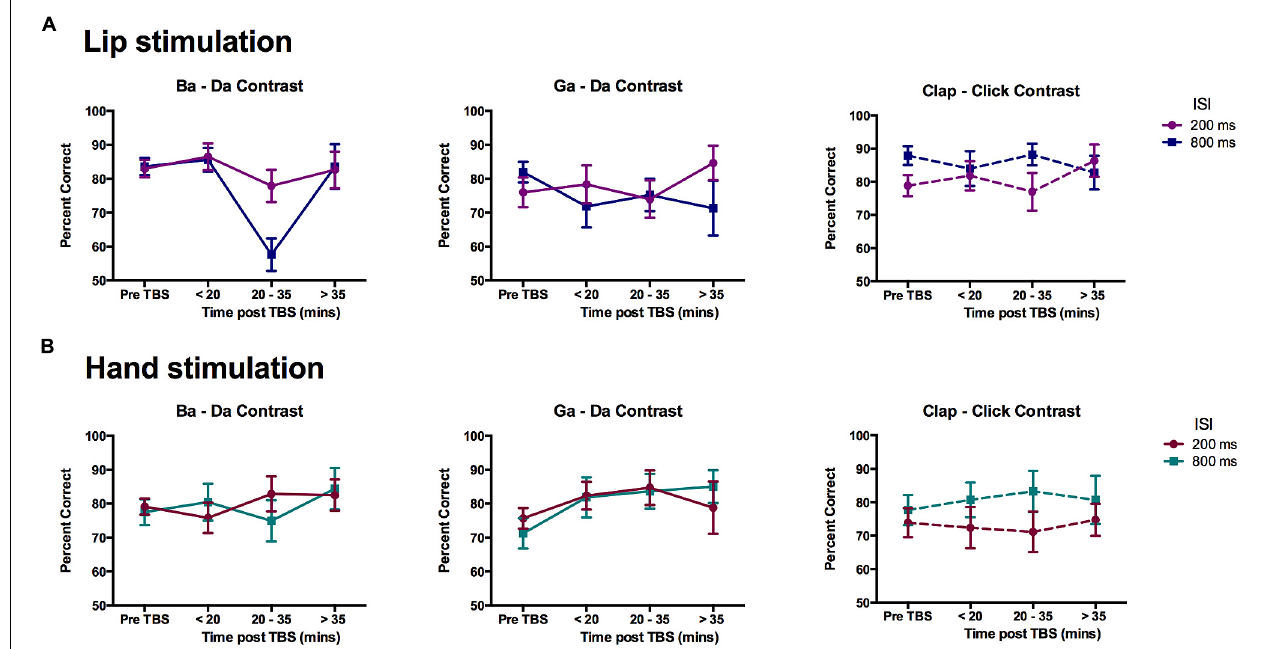
FIGURE 5 | Effects of cTBS on discrimination of across-category pairs. Mean percent correct scores for the participants in the (A) Lip stimulation group ( n = 12) and (B) Hand stimulation group ( n = 11). Data are plotted separately for each contrast.The graphs show the data for each time point in